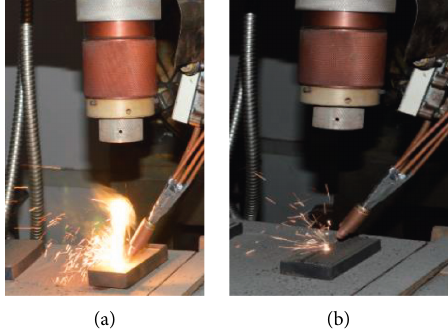
Figure 4: Oxidation of the sample during the cladding